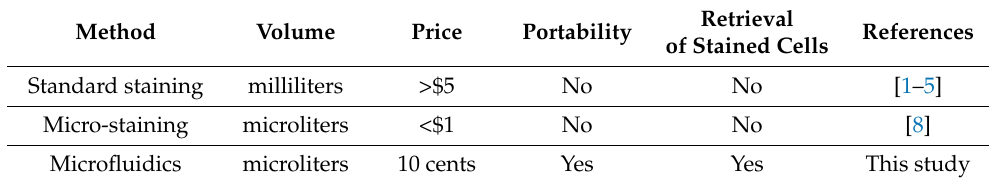
Table 2. Comparison of developed method with related staining methods in the